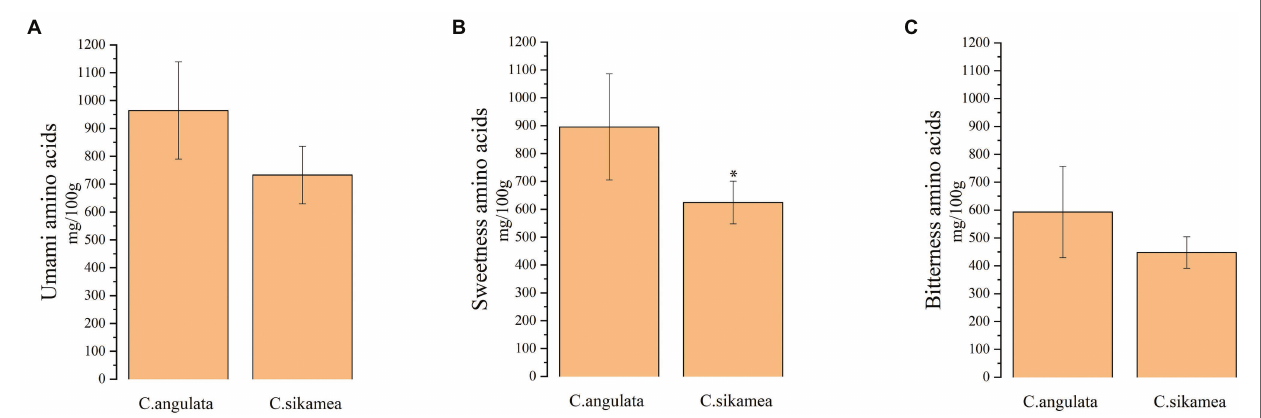
FIGURE 1 | Total of flavor amino acids content of C. sikamea and C. angulata in Xiangshan bay. (A) A total amount of umami amino acids (sum of aspartic acid and glutamic acid); (B) a total amount of sweetness amino acids (sum of serine, glycine, and alanine); (C) a total amount of bitterness amino acids (sum of histidine, arginine, tyrosine, valine, methionine, isoleucine, leucine, and phenylalanine). Data are the mean ± SD, n = 4. ∗ p < 0.05 (Student’s t